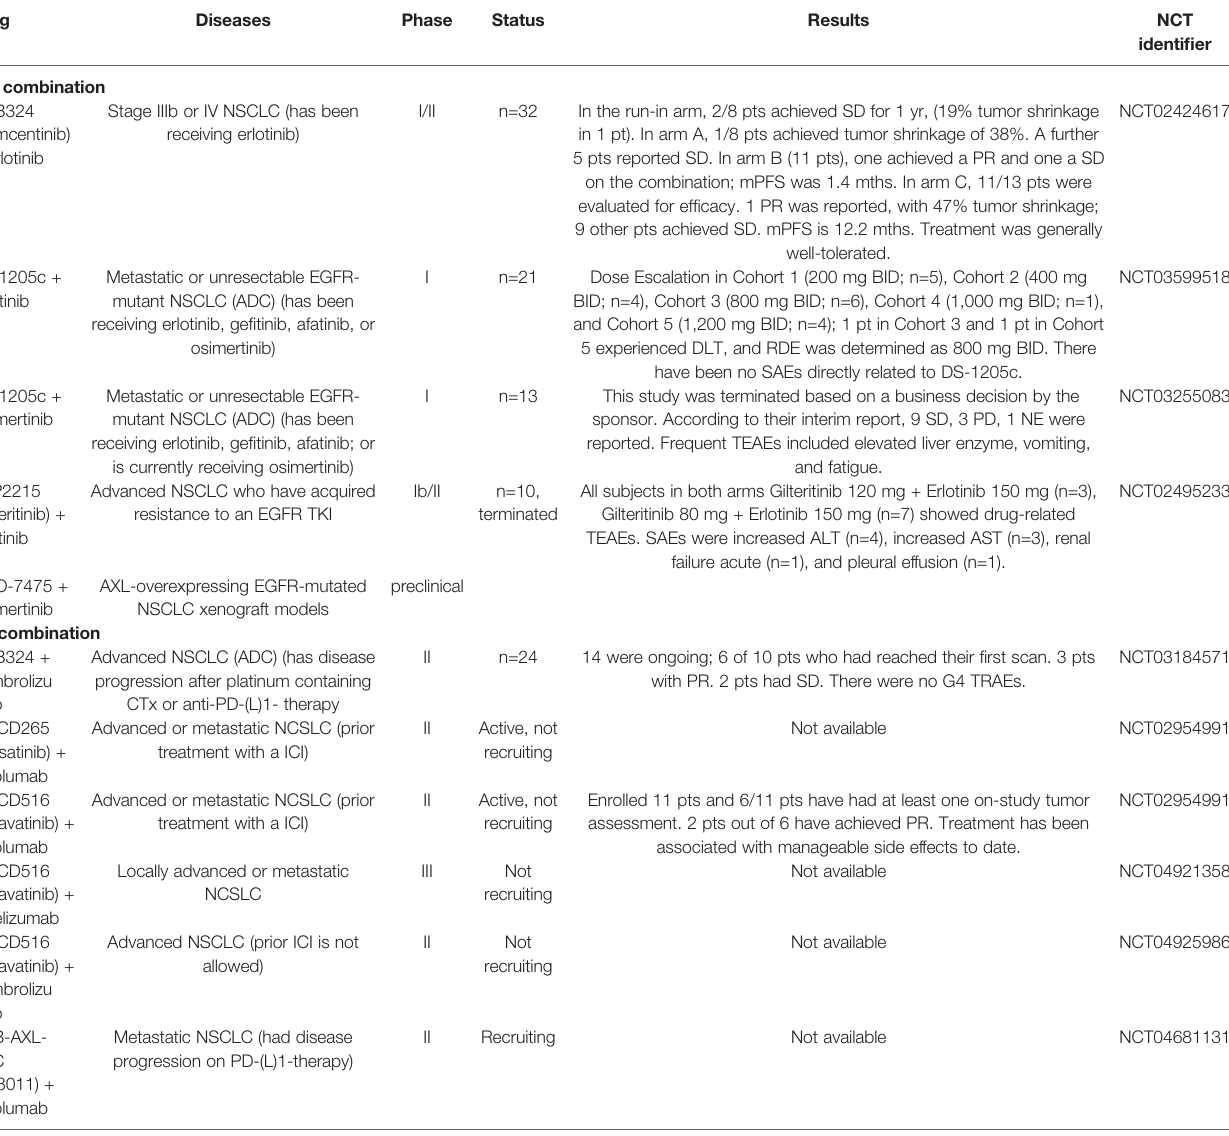
TABLE 2 | Clinical studies combining AXL inhibitor with other drugs in lung cancer.